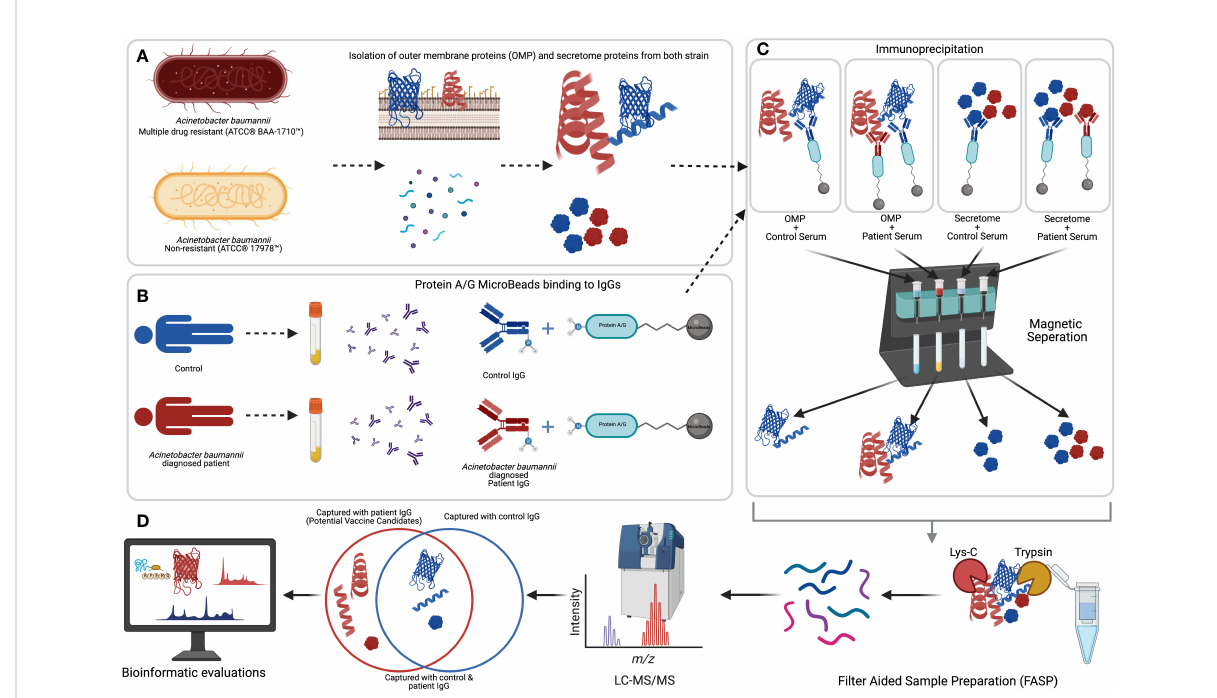
FIGURE 1 The work fl ow of our experimental strategy. (A) Isolation of the outer-membrane and secretome proteins of Acinetobacter baumannii – resistant (BAA-1710) and – sensitive (17978) strains. (B) IgGs from human sera were linked to protein A/G microbeads. (C) Protein A/G – bound IgG was utilized to bait immunodominant A. baumannii proteins from each group. (D) Sample preparations, LC-MS/MS analysis, and bioinformatic evaluations of the identi fi ed antigenic proteins. Created with